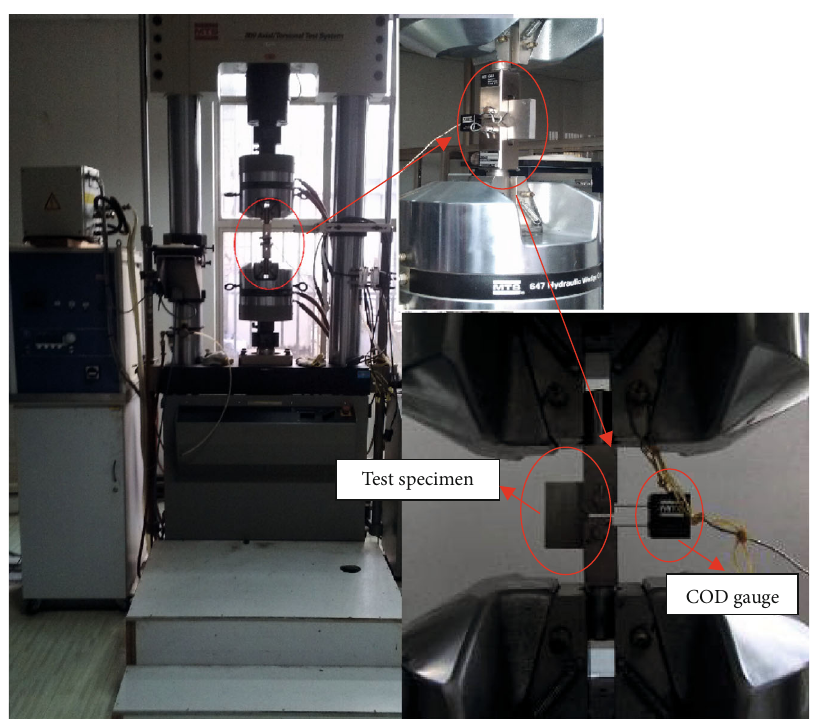
Figure 7: 809 axial/torsional test system and COD